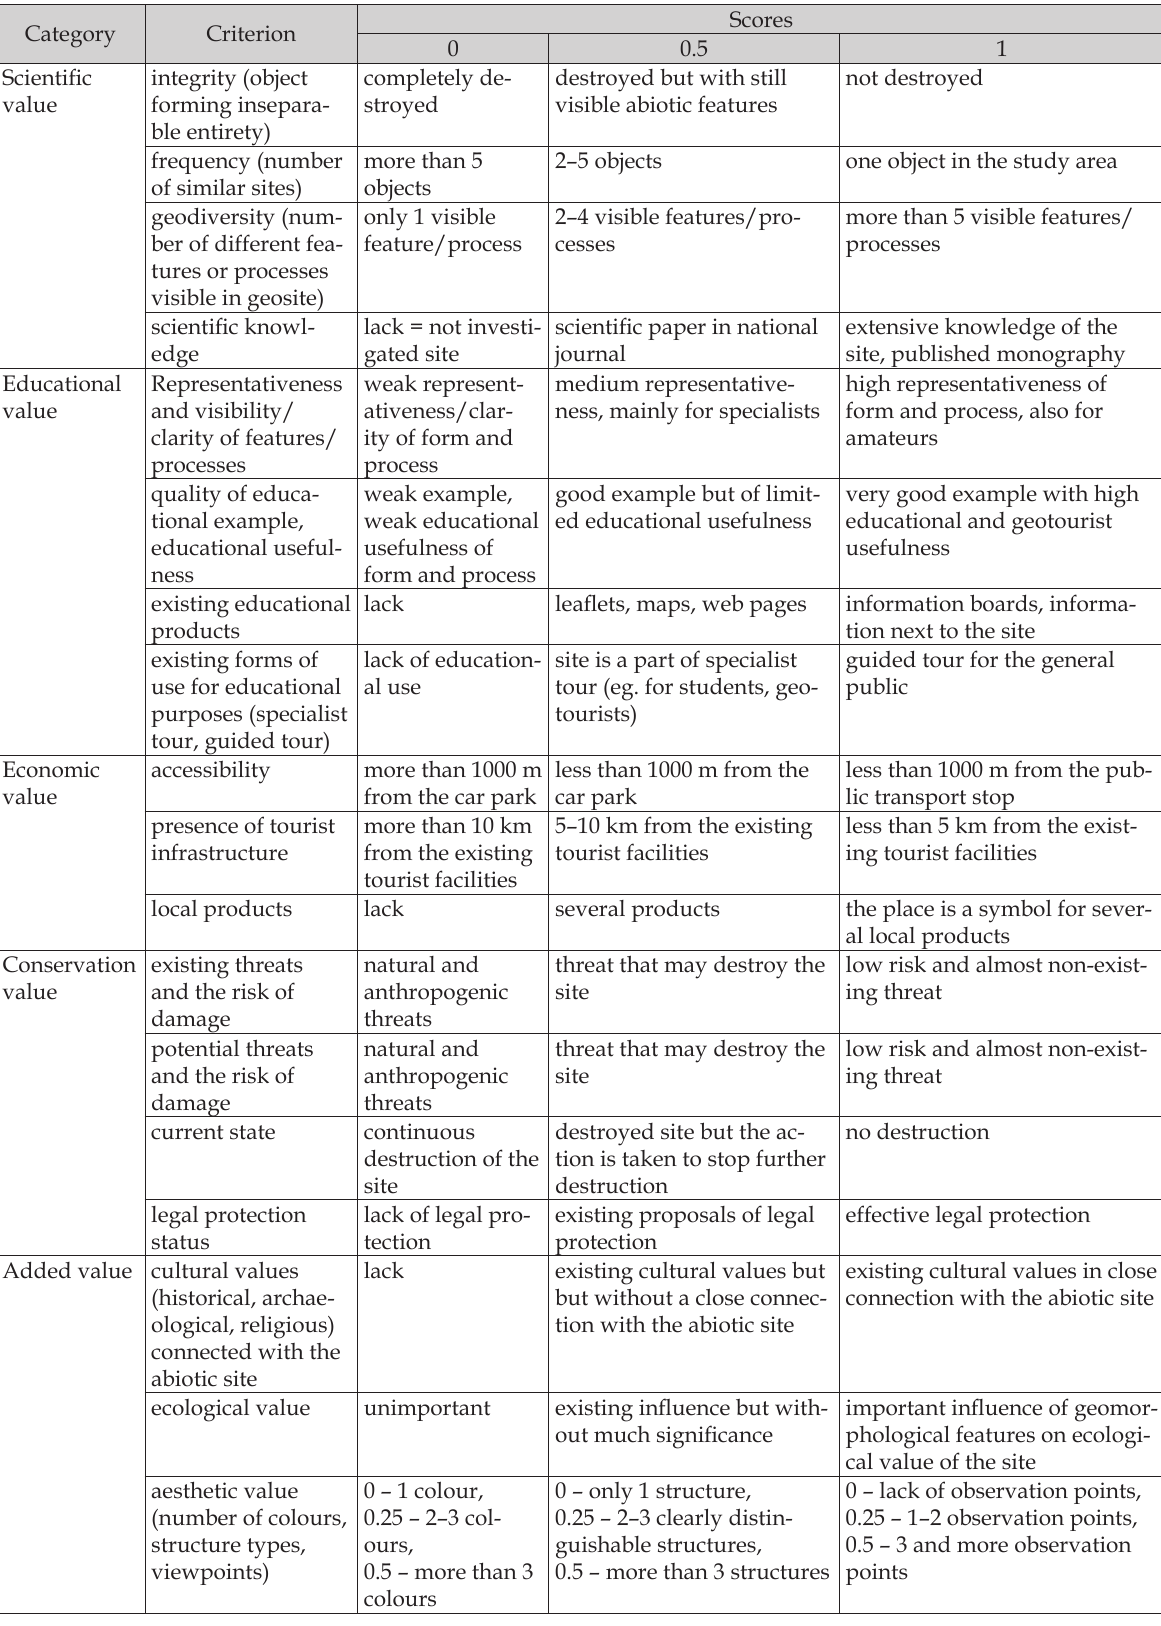
Table 1. Categories, criteria, and scoring used in this study for the evaluation of geotourism potential of the “Połczyn Switzerland”